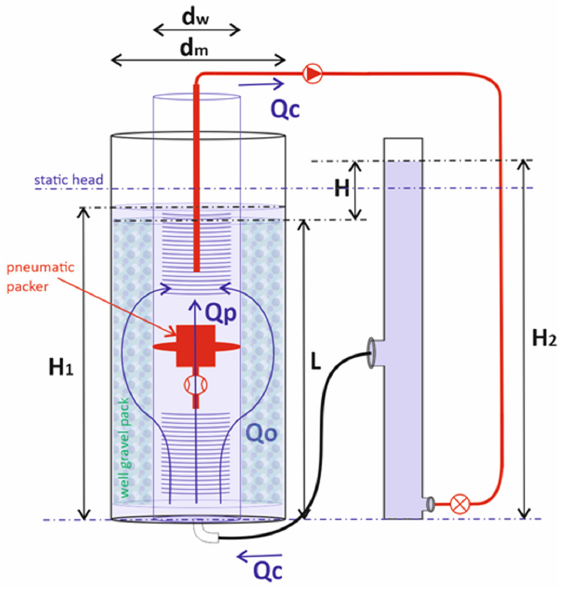
Figure 4. General scheme of laboratory tests of the INV-FLOW apparatus.